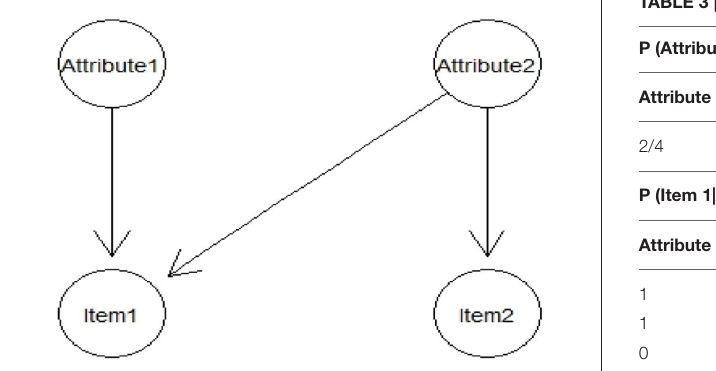
FIGURE 2 | A simple Bayesian network applied for cognitive diagnosis.